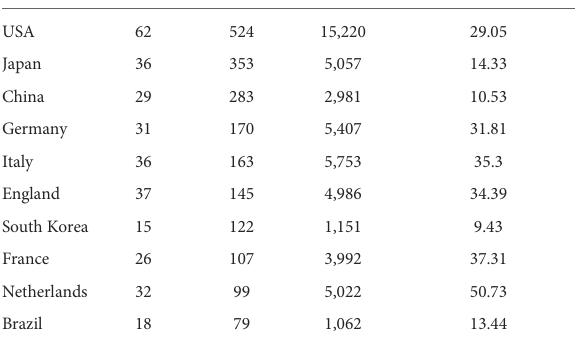
Figure 2A . Harvard University, the University of Alberta, and the University Of Milano-Bicocca had the highest TLS, and they were at the center of the collaboration map. Figure 2B showed the citation relationships between institutions. The size of nodes represents the number of citations and the line means their citation relationship. The University of Alberta received the most citations (cited times = 3,277).